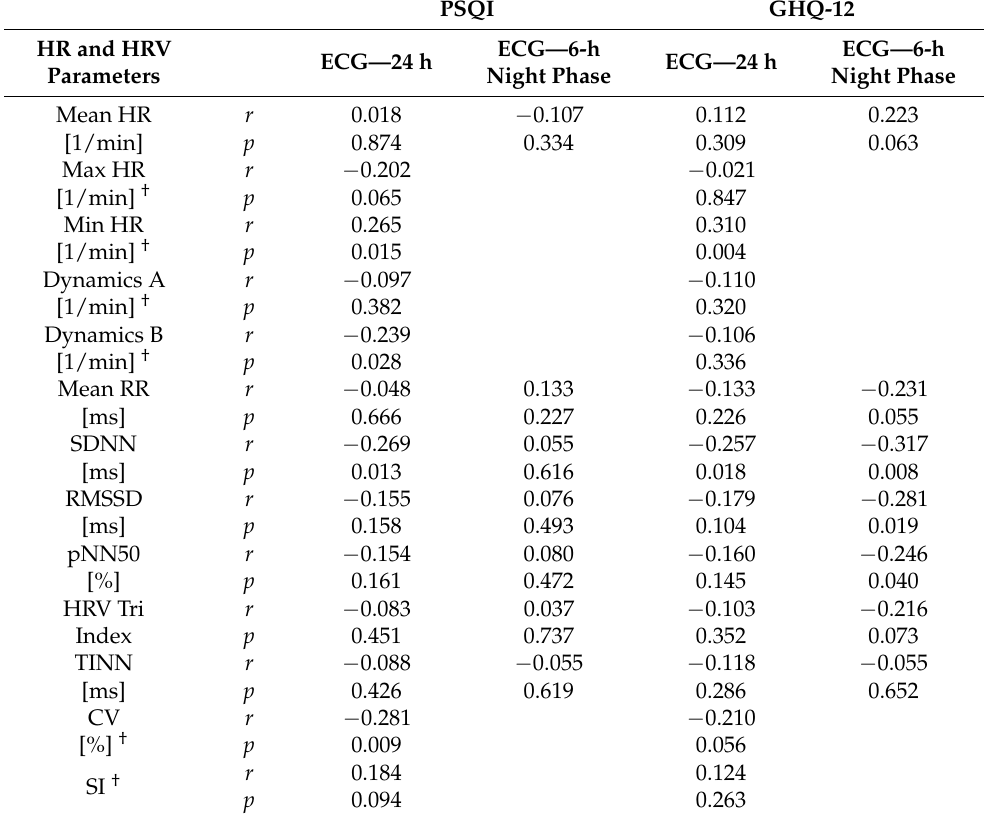
Figure 1. Correlations of GHQ-12 global score with PSQI component scores. Table 5. Correlations of PSQI and GHQ-12 global scores with HR and HRV parameters of total time (24 h) and six-hour night window.